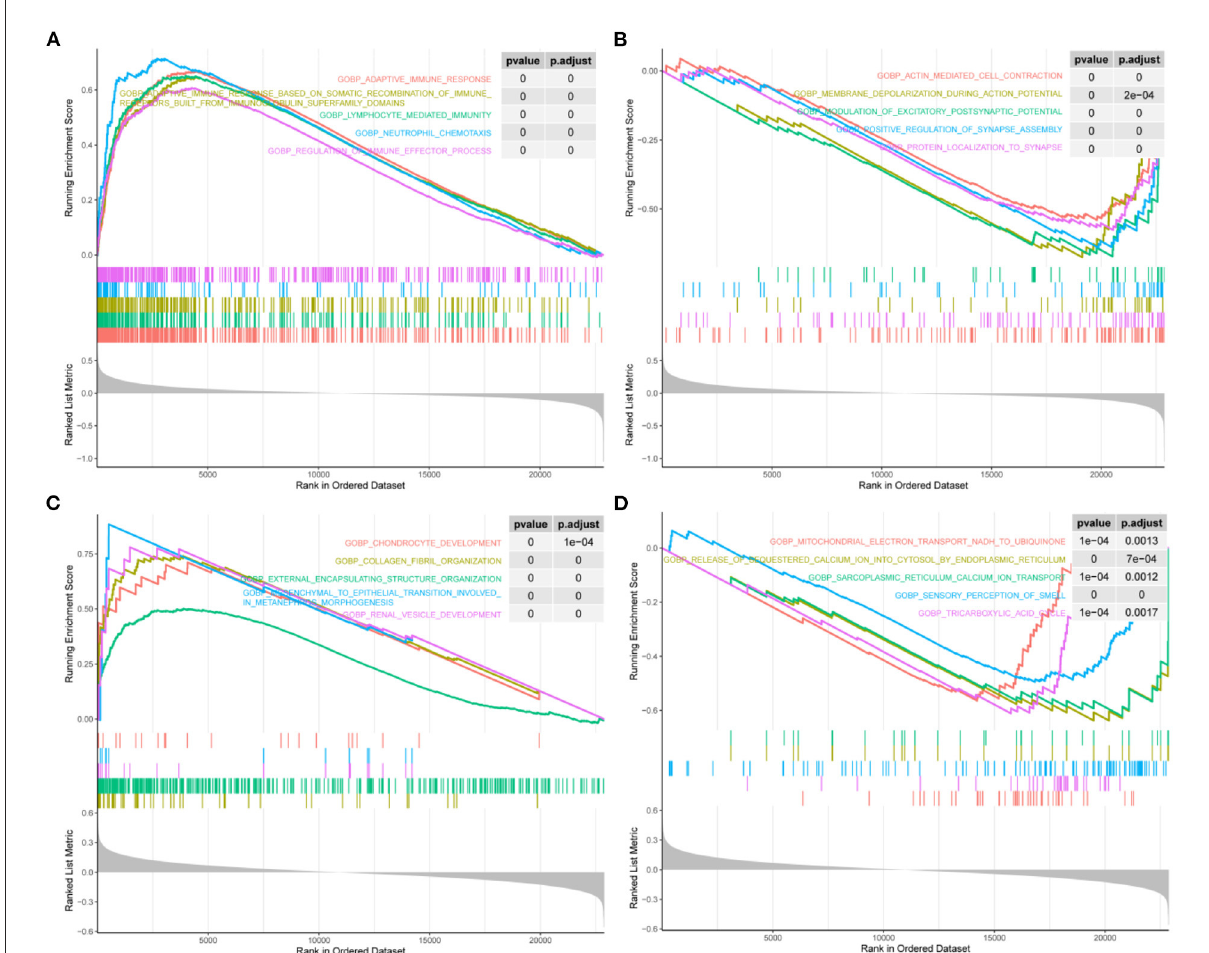
FIGURE4 Biological process pathways associated with STAT1 in intracranial aneurysm and type 2 diabetes mellitus. (A) Top 5 biological process (BP) pathways (BP) that were significantly activated in patients with intracranial aneurysm (IA) and type 2 diabetes mellitus (T2DM) with high STAT1 expression. (B) Top 5 BPs that were significantly inhibited in patients with IA and T2DM with high STAT1 expression. (C) Top 5 BPs that were significantly activated in patients with T2DM with high STAT1 expression. (D) Top 5 BPs that were significantly inhibited in patients with T2DM with high STAT1